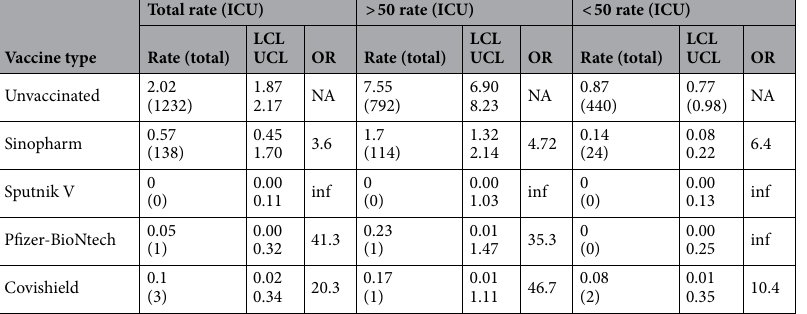
Table 3. ICU admission (%) of all SARS-Cov2 positive cases (18 + Ages) after Jan 30th. *In pairwise comparison to unvaccinated individuals all p-values are < 0.001. Inf refers to an infinite OR, since the rate was